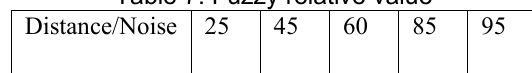
Table 7. Fuzzy relative